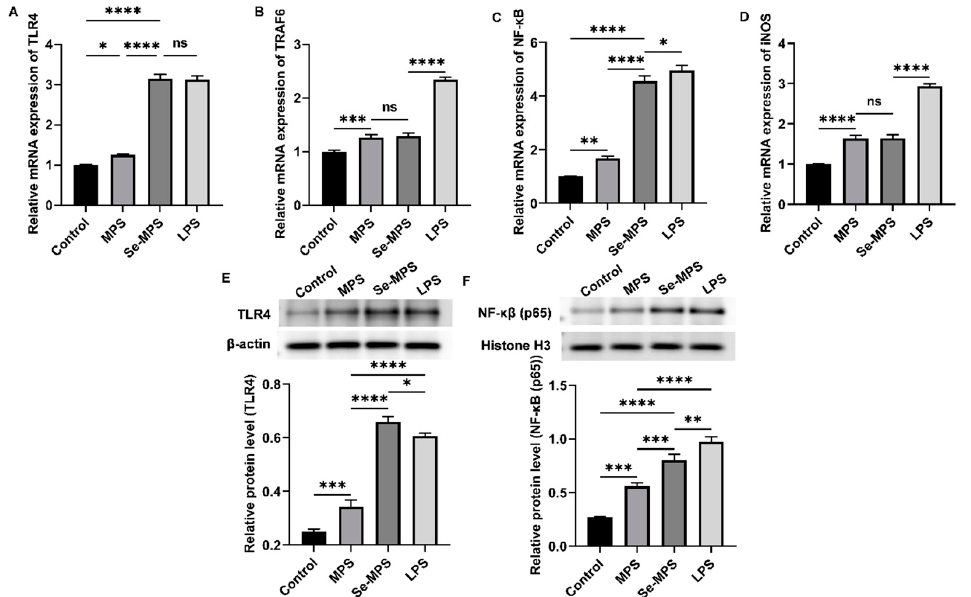
Figure 7. Key mRNA expression levels of TLR4 ( A ), TRAF6 ( B ), NF- κ B ( C ), and iNOS ( D ), and protein expression levels of TLR4 ( E ) and NF- κ B ( F ) in RAW 264.7 cells treated with MPS and Se-MPS. *, p < 0.05; **, p < 0.01, ***, p < 0.001; ****, p < 0.0001; ns, not significant; MPS— Morel polysaccharide; Se-MPS—Se-enriched Morel polysaccharide; LPS—lipopolysaccharide.